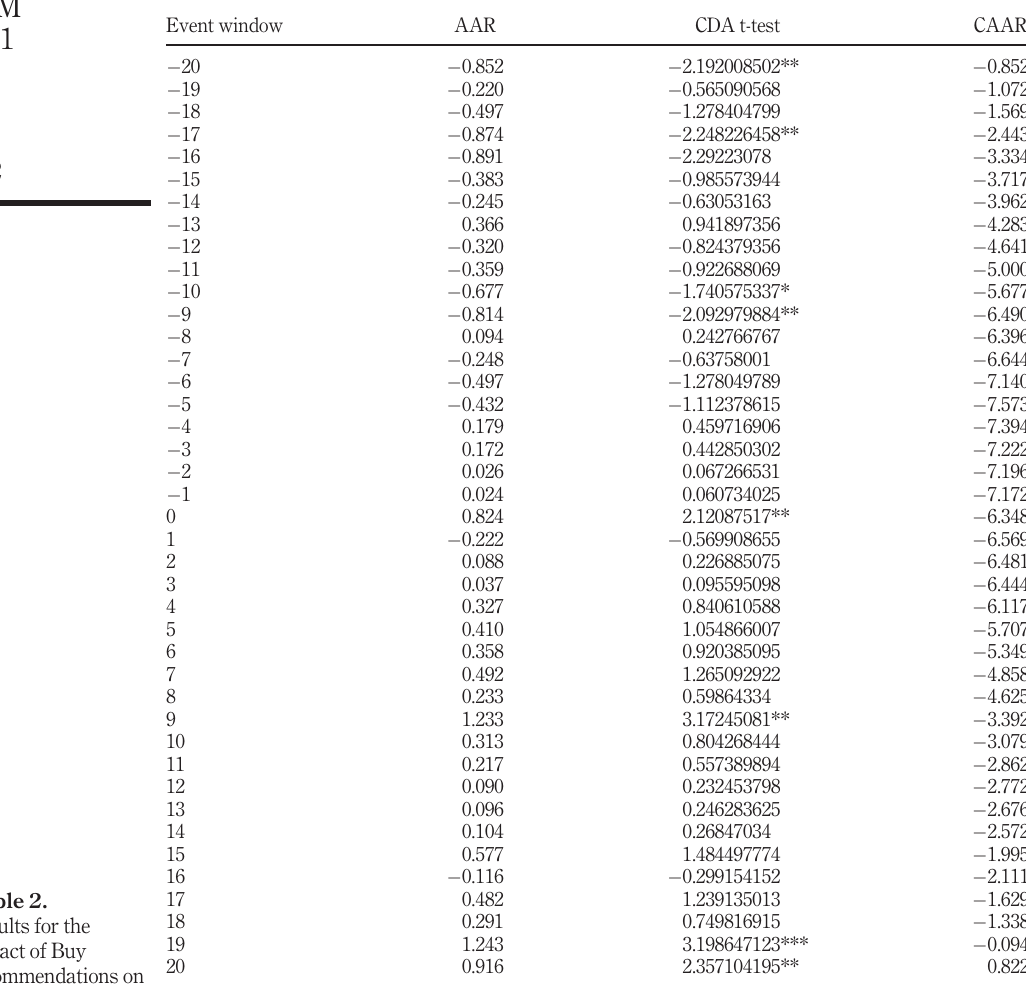
Table 2. Results for the impact of Buy recommendations on average abnormal returns (AARs) and